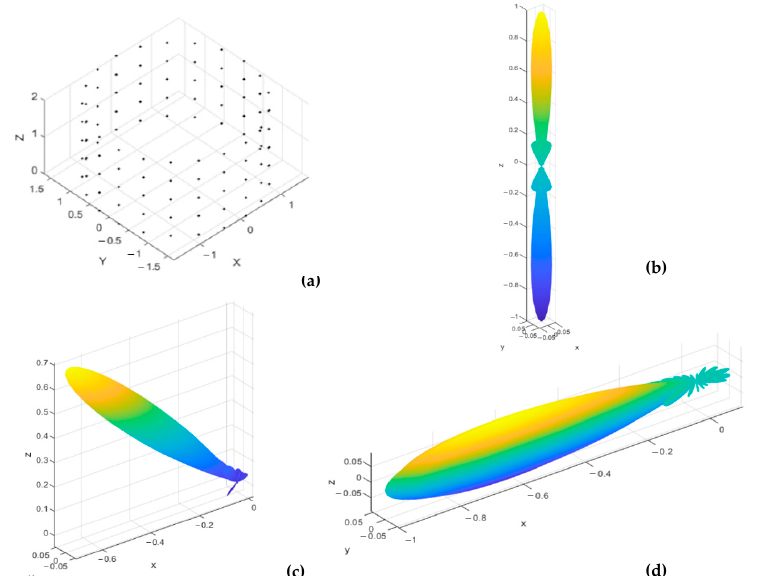
Figure 3. Uniform cylindrical array structure and beam characteristics at three mainlobe directions: ( a ) array structure, ( b ) normalized 3D power pattern for a mainlobe at (0°,180°) , ( c ) normalized 3D power pattern for a mainlobe at (45°,180°) , and ( d ) normalized 3D power pattern for a mainlobe at (90°,180°) .